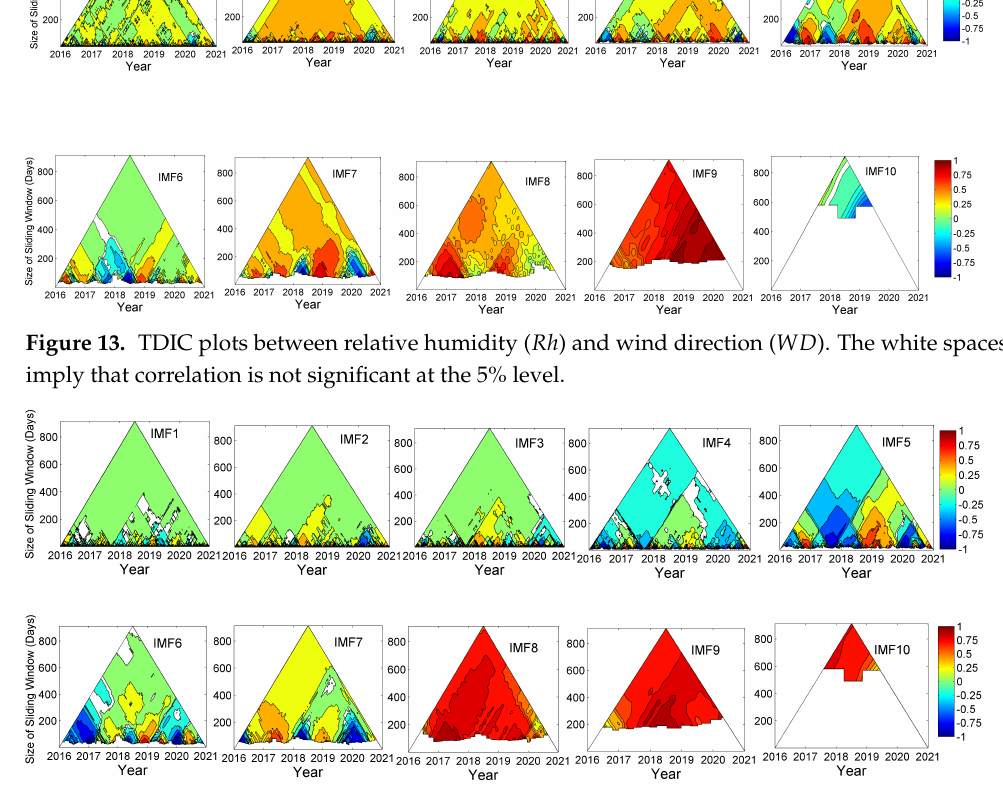
Figure 14. TDIC plots between rainfall ( R ) and wind direction ( WD ). The white spaces imply that correlation is not significant at the 5%